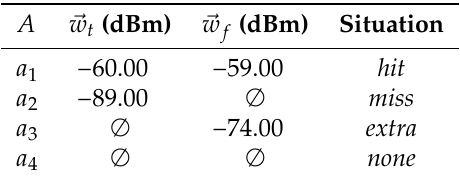
Table 1. The relevant literature is not always clear how to apply the sensor model on training data (cid:126) w t and measurement (cid:126) w f when some access points are not received ( ∅ ) in either of the two fingerprints. A (cid:126) w t (dBm) (cid:126) w f (dBm) a 1 −60.00 −59.00 −89.00 ∅ miss ∅ −74.00 extra a 4 ∅ ∅